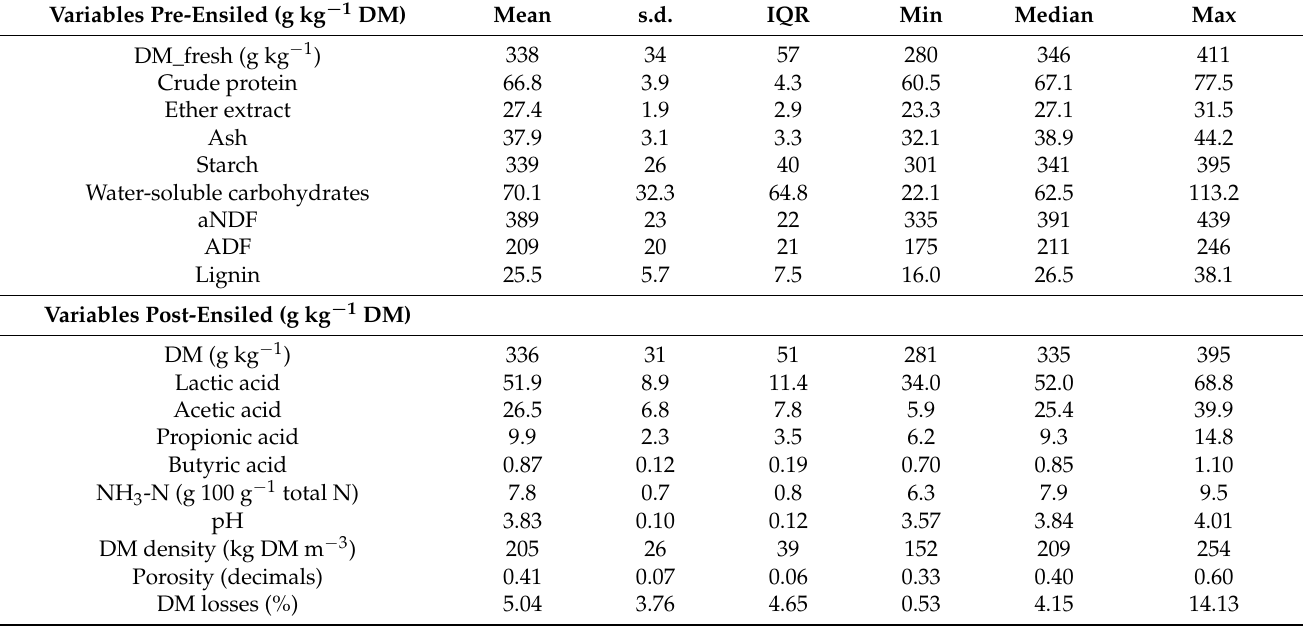
Table 1. Descriptive statistics for the chemical traits of green chopped whole-plant maize (WPM) and for dry matter (DM), fermentative profile (acids, ammonia, pH), porosity, DM density, and DM losses (DML) of post-ensiled